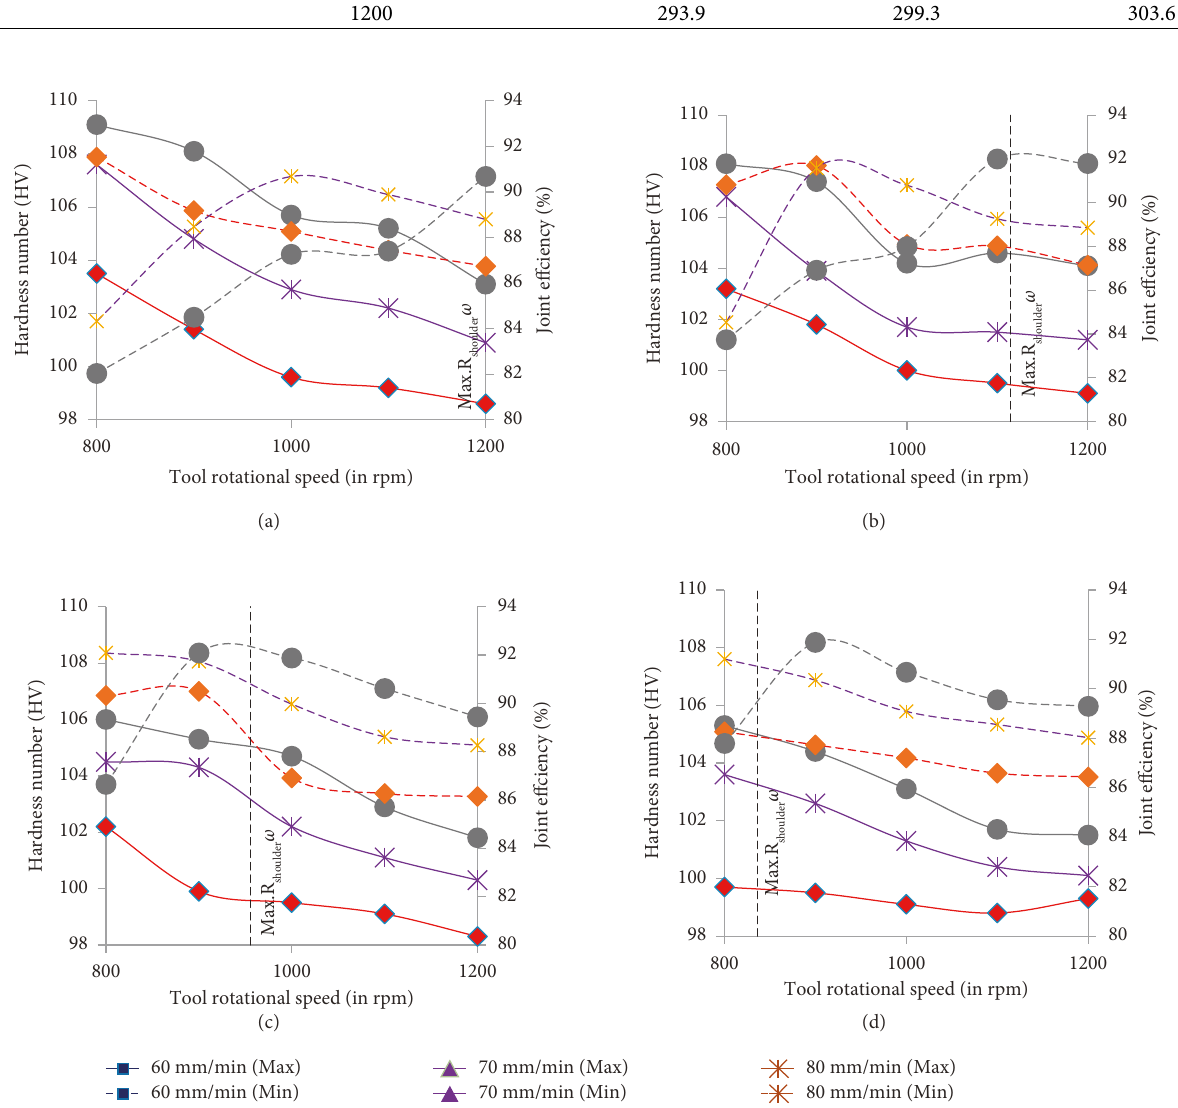
Figure 6: Joint efficiency and lowest hardness value. (a) R R shoulder �